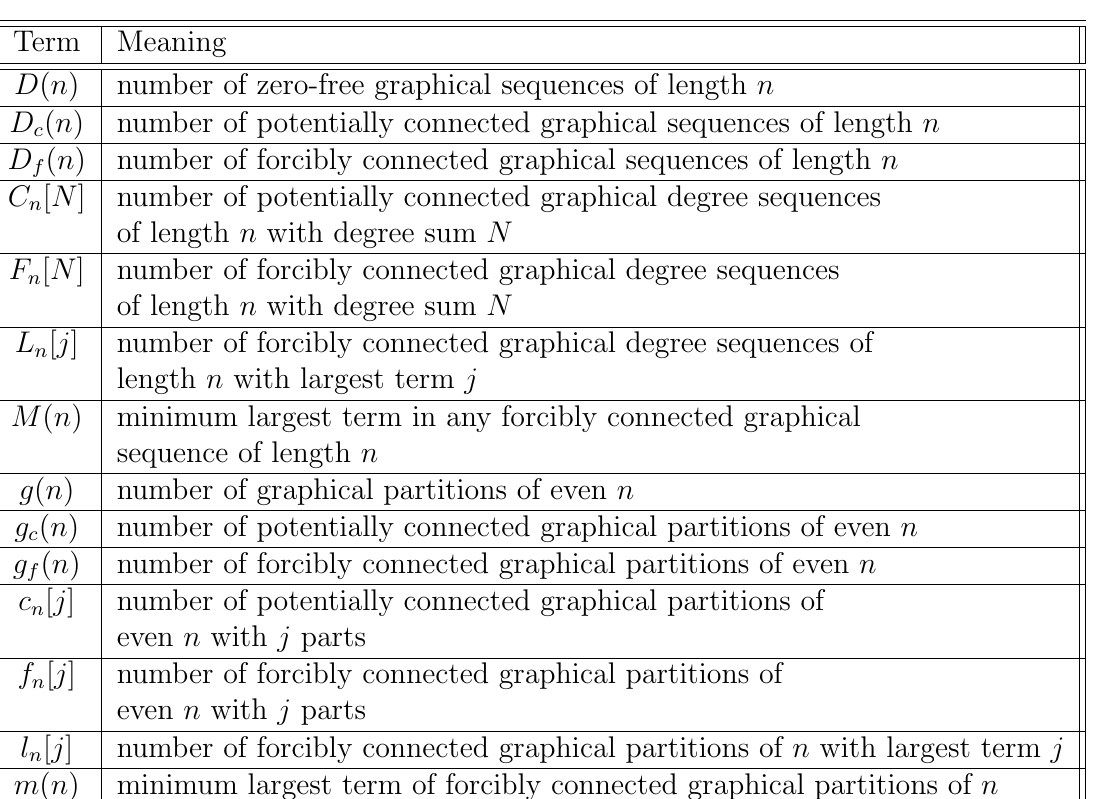
Table 3: Terminology used in this